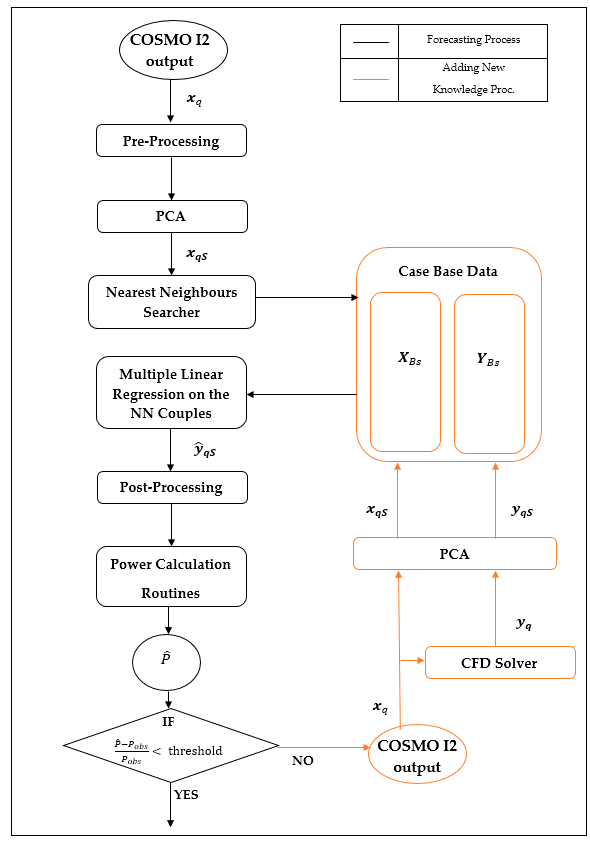
Figure 3. Flowchart of the proposed CBR-based framework.